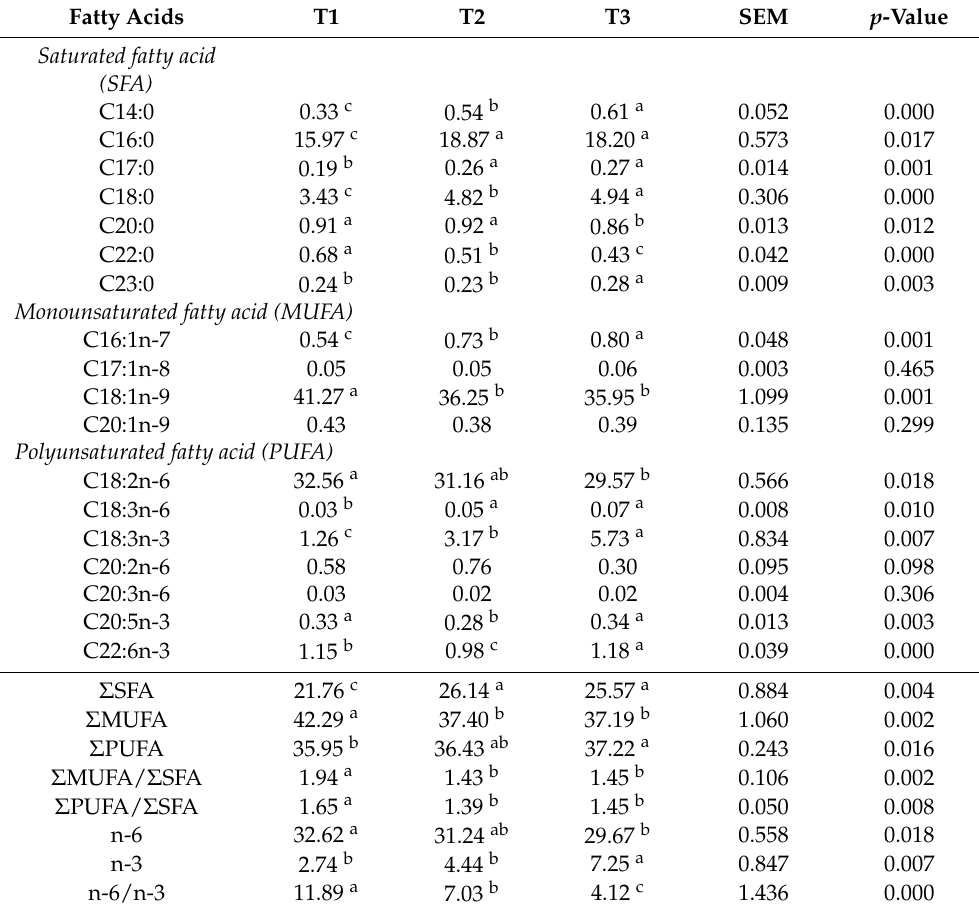
Table 2. Compositions of fatty acids in three dietary treatments fed to the finishing crossbred pigs (g/100 g of total fatty